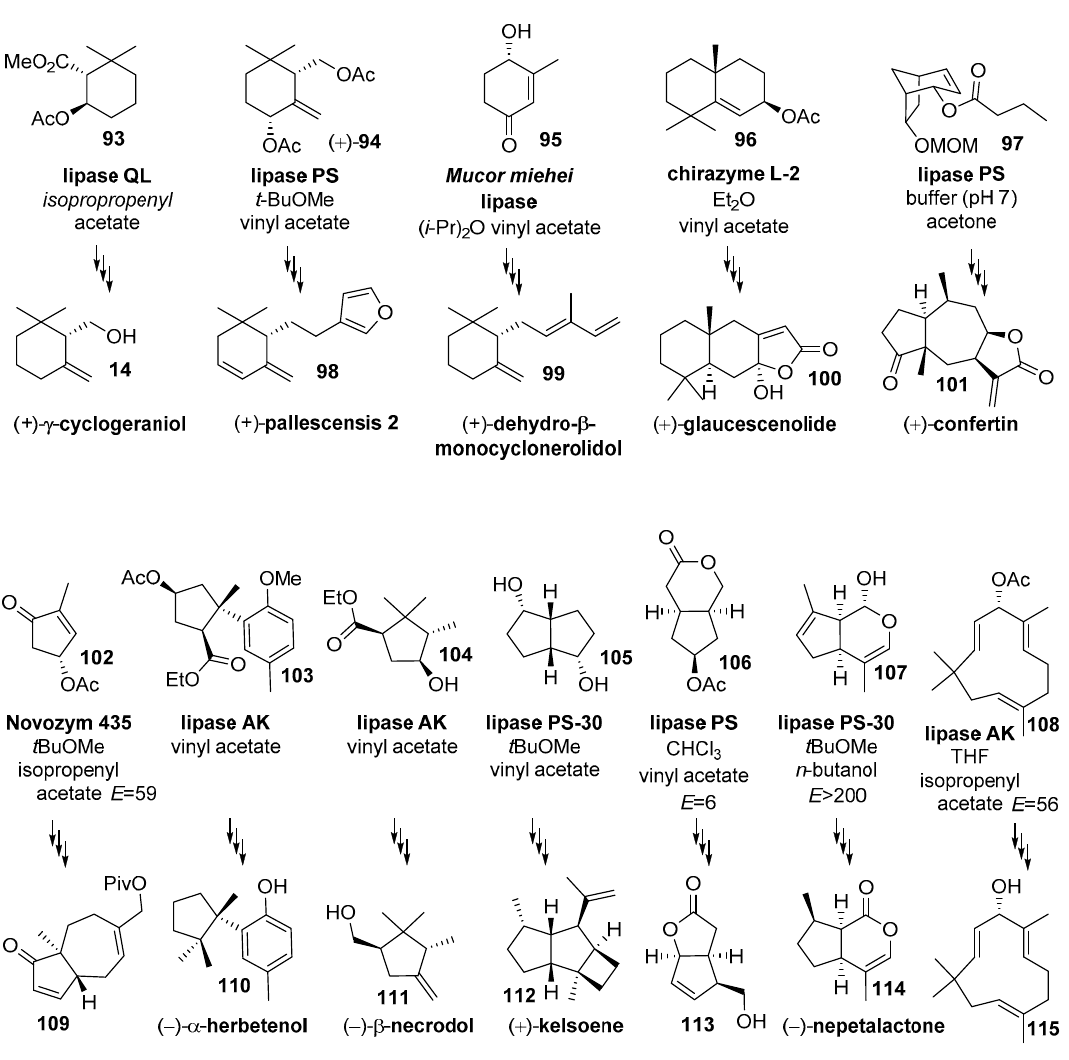
Figure 16. Terpenes and terpenoids prepared by using enantioenriched building blocks obtained by lipase-mediated resolution of cyclic secondary alcohols. The figure describes the enantioenriched compounds obtained by lipase resolution ( 93 – 97 and 102 – 108 ), the lipase used and the resolution conditions (below chemical structure), and the terpene derivatives ( 14 , 98 – 101 , 109 – 115 ) prepared by using the described chiral building blocks.